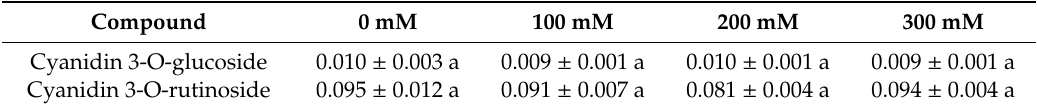
Table 2. The accumulation of anthocyanin under salinity stress in tartary buckwheat plants. (Average ± STDEV, mg / g dry wt.). The means and standard deviations were obtained from three independent experiments. Letters a indicate significant di ff erences ( p < 0.05).